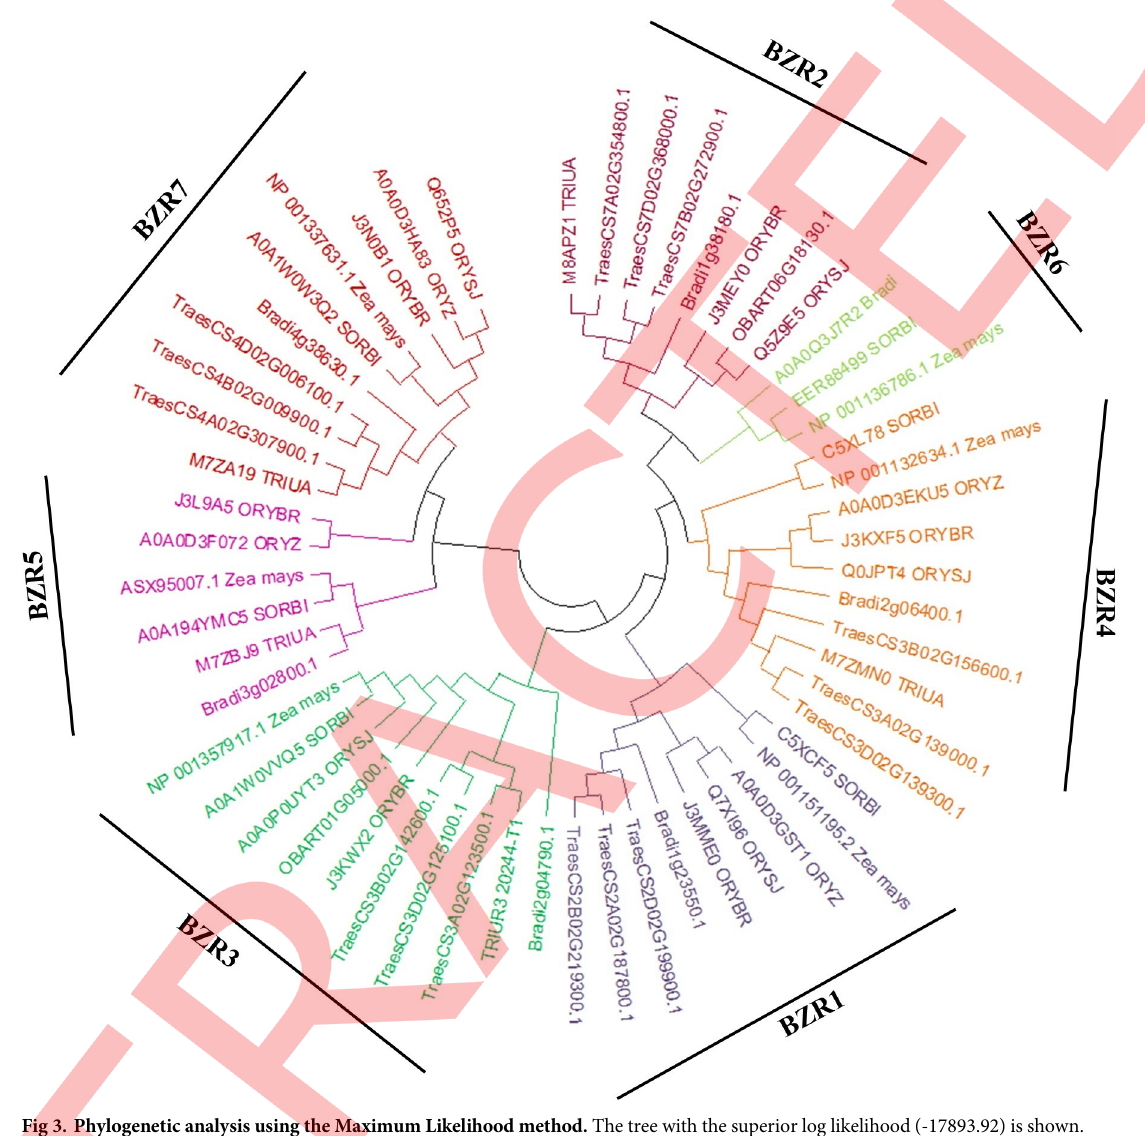
Fig 3. Phylogenetic analysis using the Maximum Likelihood method. The tree with the superior log likelihood (-17893.92) is shown. The analysis of BZR involved 56 amino acid sequences. There was a total of 920 positions in the final